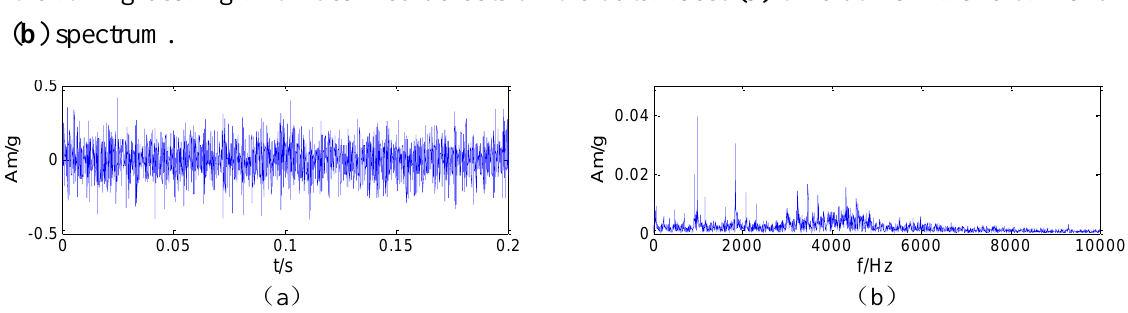
Figure 1. The time domain waveform and spectrum of the vibration acceleration signal of the rolling bearing with localized defects on the outer race: ( a ) time domain waveform and ( b ) spectrum.